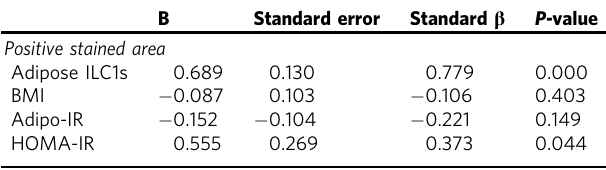
Table 3 Multivariate stepwise regression